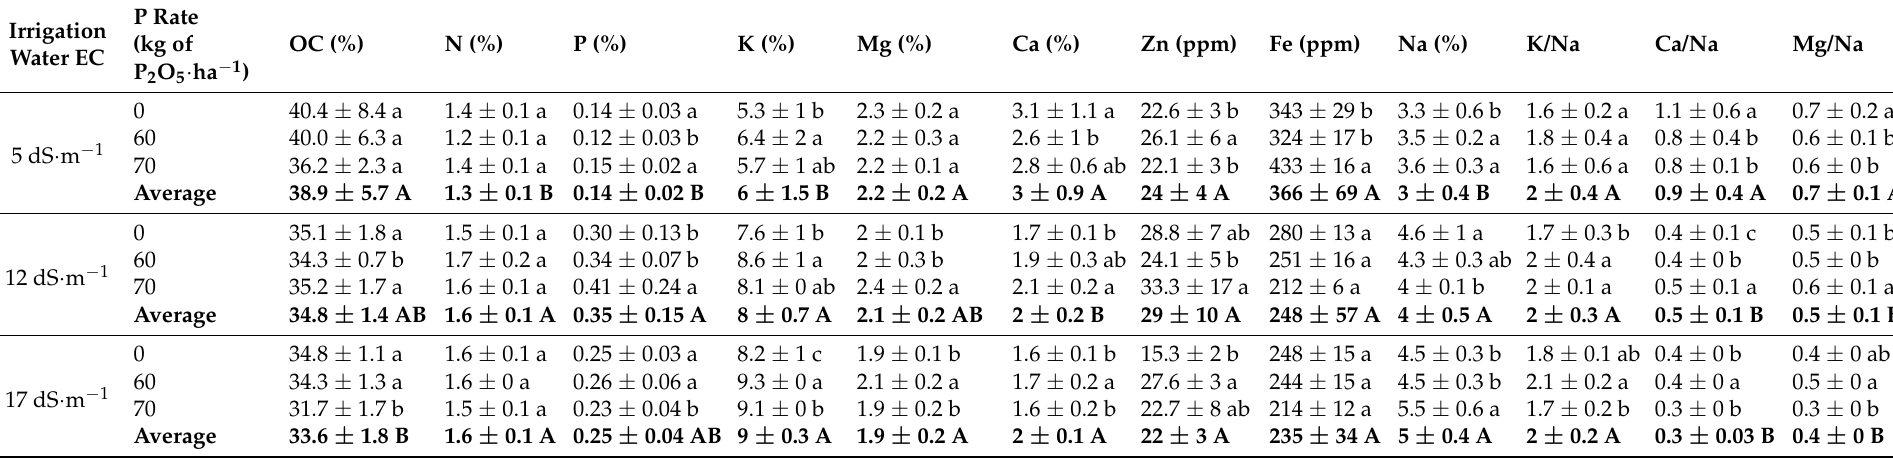
Table 2. Macro- and micro-nutrient content in quinoa leaves as affected by irrigation water salinity and phosphorus fertilizer rate. Any two values within a column are significantly different ( p ≤ 0.05) if they have no letter in common. Small and same letters (a, ab, b) indicate the statistically homogeneous groups within phosphorus fertilization treatments, and capital and same letters (A, AB, B) indicate the statistically homogeneous groups within salinity